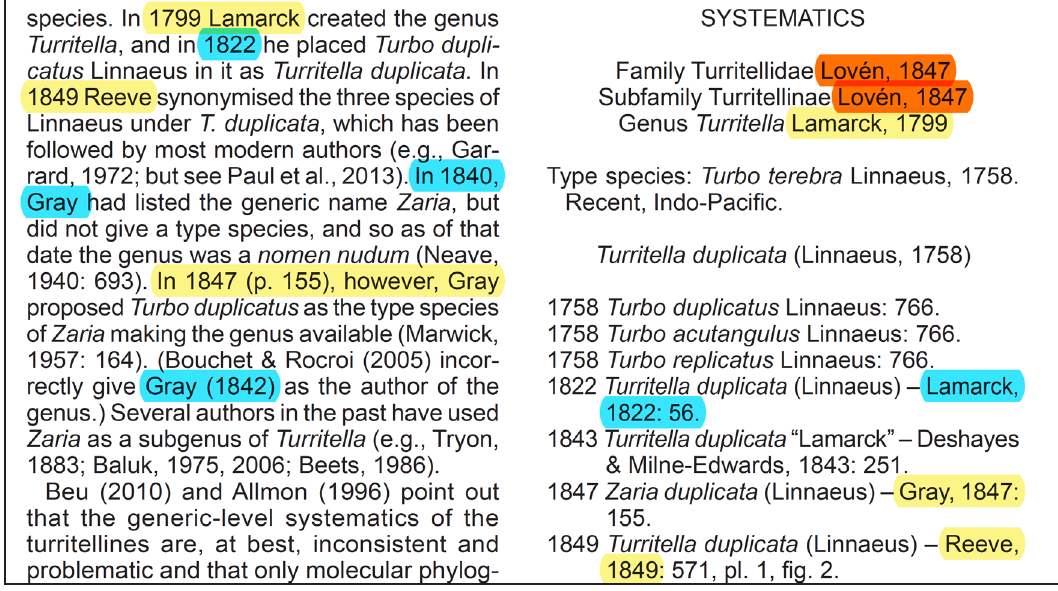
Fig. 7. In this article the reference highlighted in orange indicates a reference that is only cited under taxonomic treatment and listed under the references section; in yellow a reference that is cited elsewhere thus listed under the references section; in blue are the references that should have been listed but are not in the references section (Waite R. & Allmon W.D.